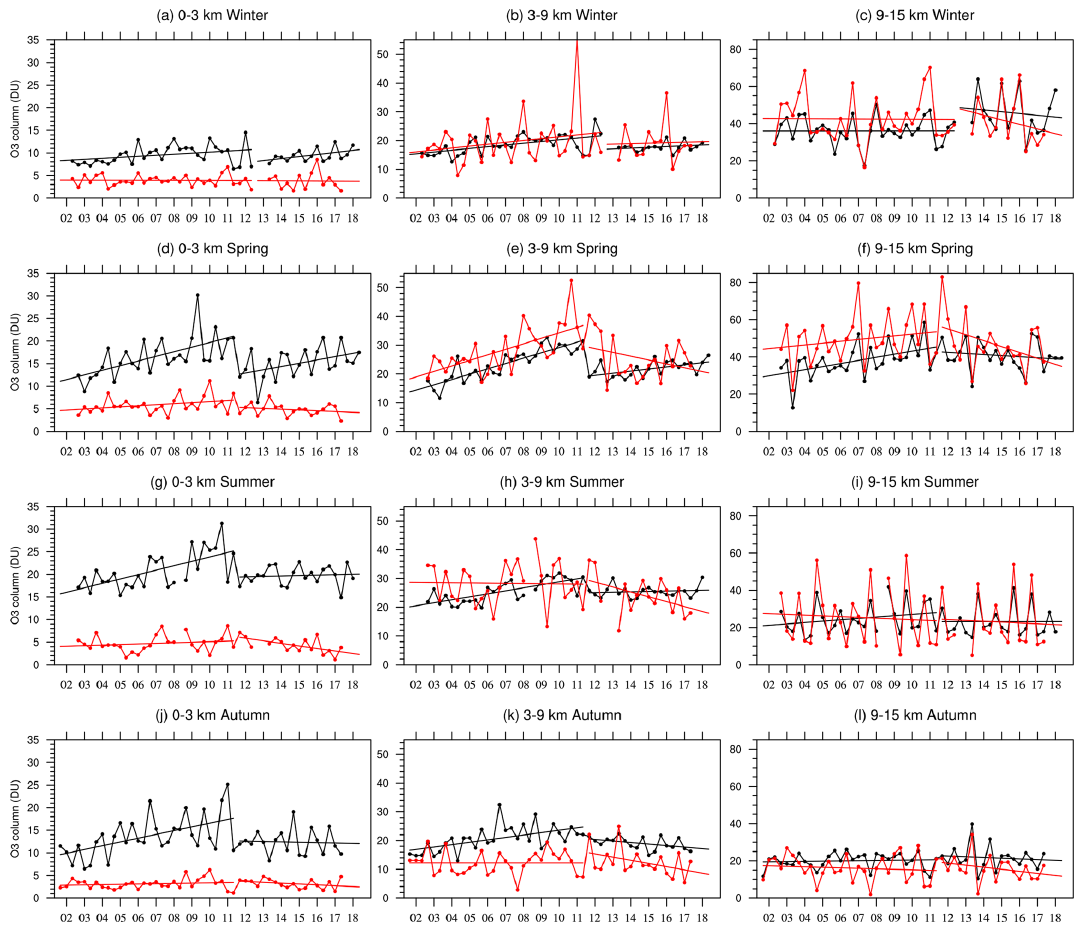
Figure 6. Monthly mean column ozone (DU) from the ozonesonde observations (black) and CLaMS simulations (red) in four seasons. Trends of column are calculated before and after the sudden decrease of ozone in 2011–2012. There are 3-monthly values in each year for each